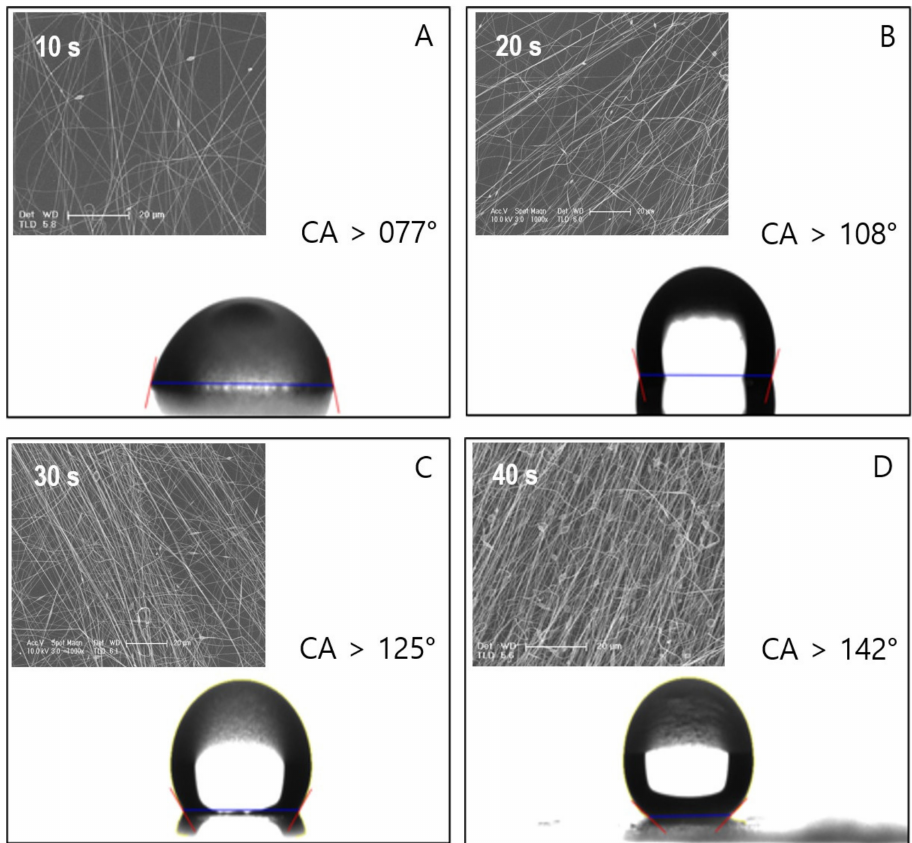
Figure 7. Water contact angle and SEM images of the aligned network of PS electrospun fibers deposited with deposition times of ( A ) 10, ( B ) 20, ( C ) 30, and ( D ) 40 s. The applied voltage is 10 kV and the working distance is 15